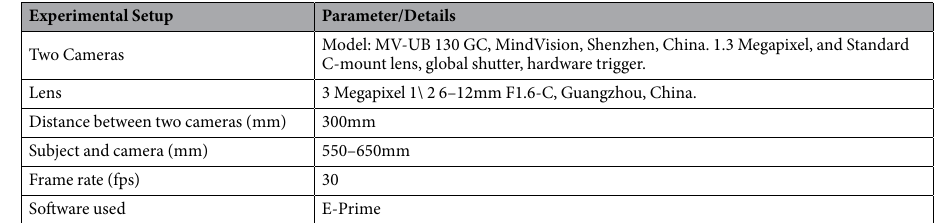
Table 3. Experimental setup to acquire spontaneous facial expression videos.